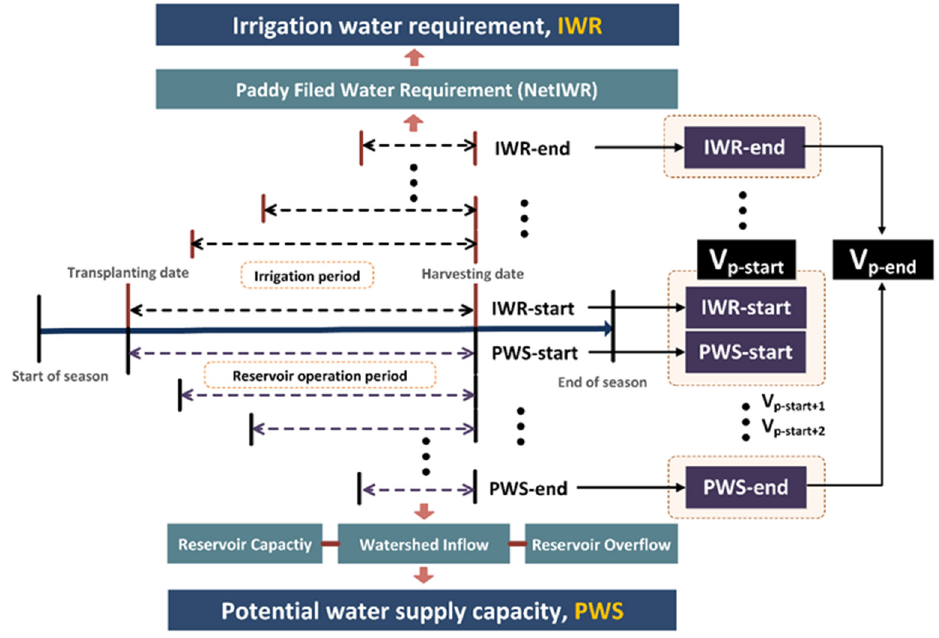
Figure 4. Definition of the potential water supply capacity and irrigation water requirement.